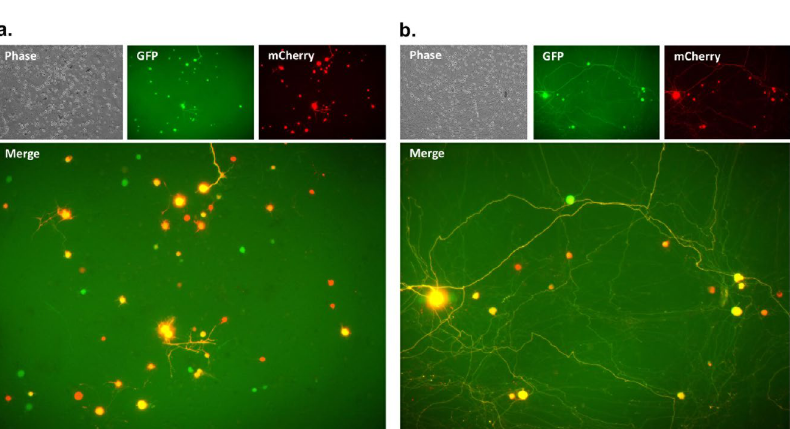
Figure 5. AAV co-transduction of sensory neurons in the trigeminal ganglia. ( a , b ) Swiss Webster mice were inoculated by intradermal injection of the whiskerpad with PBS or with 2 × 10 11 vector genomes of scAAV1-smCBA-mCherry and 2 × 10 11 vector genomes of scAAV1-smCBA-GFP. At 21 days post AAV delivery trigeminal ganglia were harvested and primary explant cultures were established to analyze numbers of mCherry and GFP positive cells by fluorescence microscopy. Representative images of primary sensory neuronal cultures are shown for 3 ( a ) and 29 days ( b ) post explant. For quantification GFP and mCherry positive neurons were counted in a total of 10 fields of view for each neuronal culture over 29